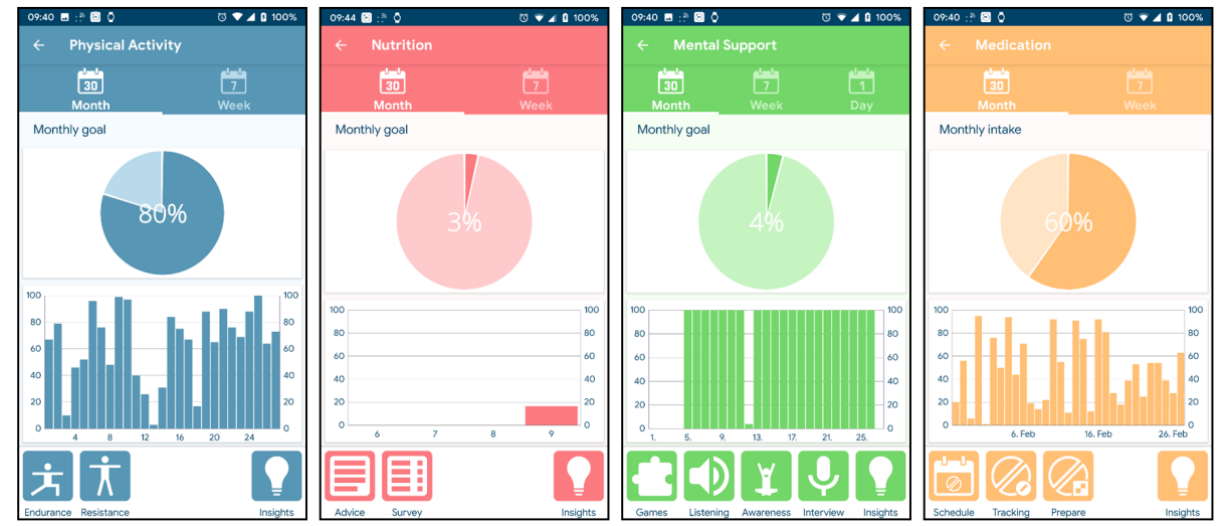
Figure 5. Dashboards of the HeartMan mobile app for physical activity, nutrition, mental support, and medication